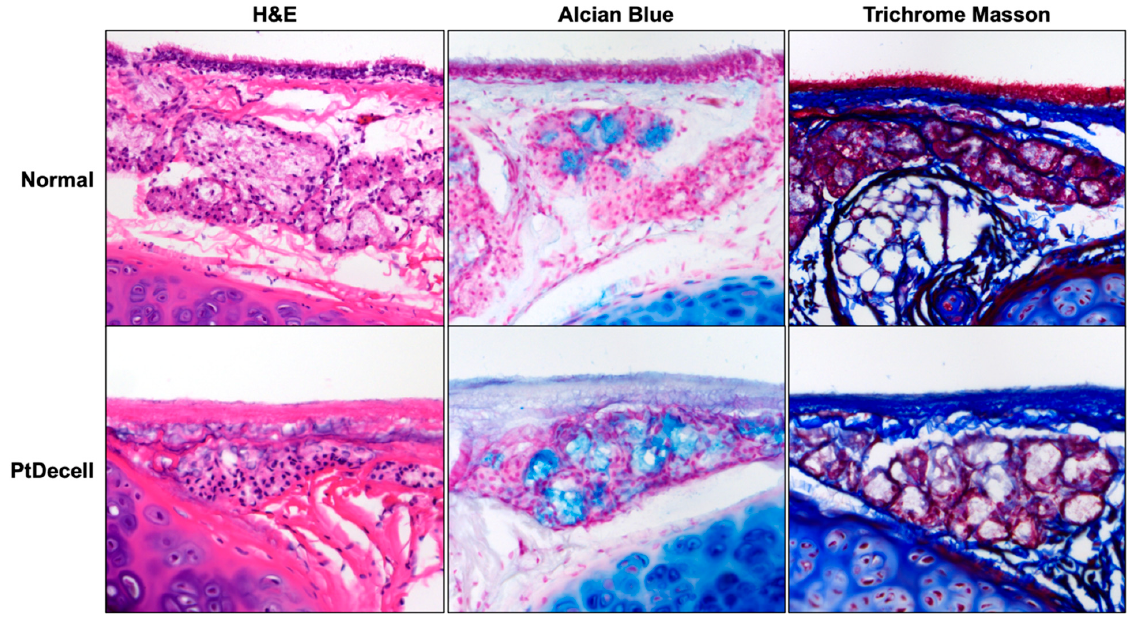
Figure 5. Histologic evaluation of partly decellularized tracheas. Compared with normal tracheas, the partly decellularized tracheas demonstrated the complete absence of luminal cells. Alcian blue staining confirmed that the mucin-containing submucosal glands were still intact and present in the submucosa. Trichrome Masson staining is a comparative stain for collagen, which subjectively appeared to be unchanged on the luminal surface.